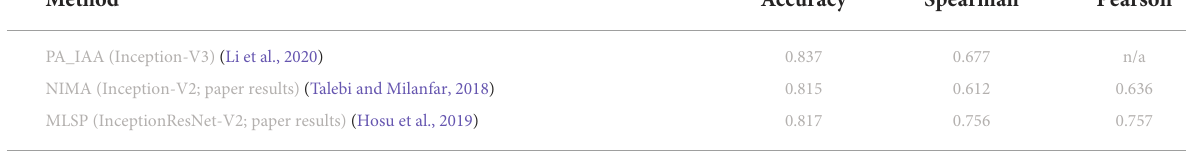
TABLE 1 Comparison between the results of all our models and the results of existing models, which were published in their respective papers. Method